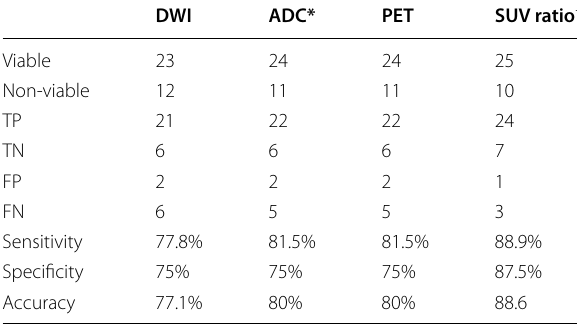
Table 1 Diagnostic performance of DWI, ADC, SUV ratio and functional imaging